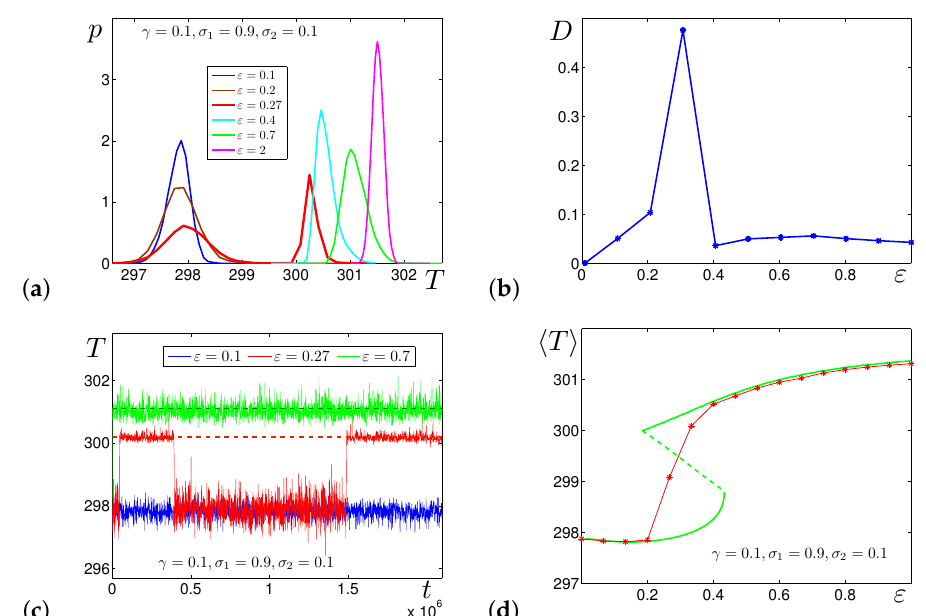
Figure 11. Stochastic transformations in the system (2), (3) with γ = 0.1, σ 1 = 0.9, σ 2 = 0.1: ( a ) probability density functions, ( b ) variance of random states versus ε , ( c ) time series, ( d ) mean values of T -coordinates (asterisks) and theoretical curves